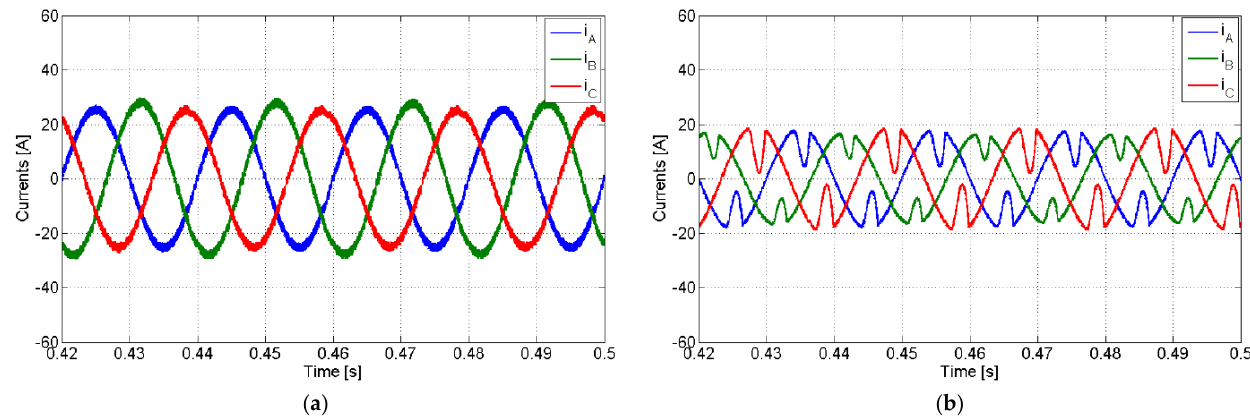
Figure 19. Simulation results with the PV generator in overcompensation mode with a non-linear load and compensation of the active power imbalance: ( a ) AC currents of the PV generator; ( b ) grid currents.